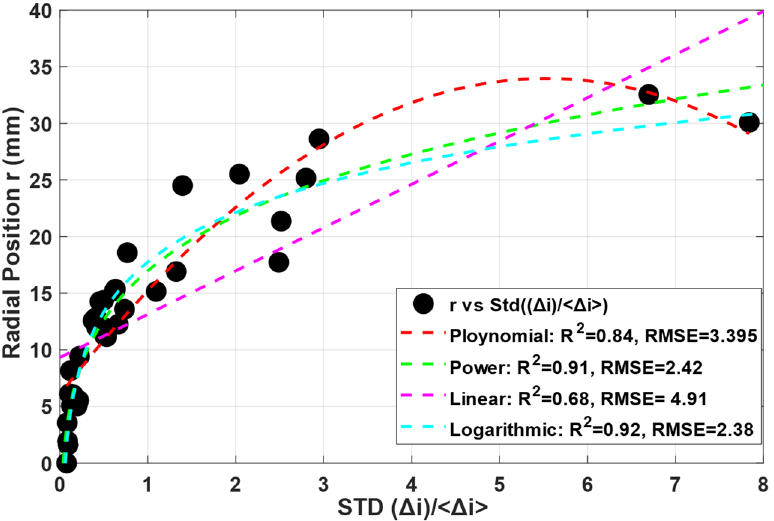
Figure 9. Fit obtained by plotting the standard deviation of the normalized current divided by its average against the radial position of the phantoms placed at different locations inside the domain. The blue dashed line represents the fit.